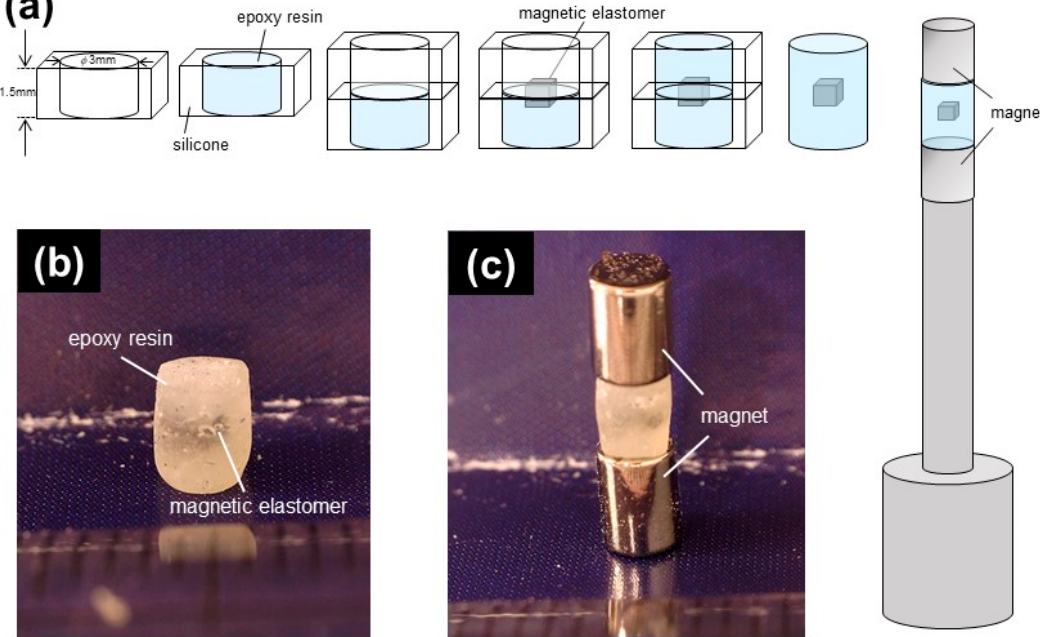
Figure 1. ( a ) Schemes of sample preparation for CT observations; a piece of magnetic elastomer was placed in epoxy resin. Photos of samples at ( b ) 0 mT and ( c ) 270 mT; sample was sandwiched by two permanent magnets with a magnetic field of 490 mT.